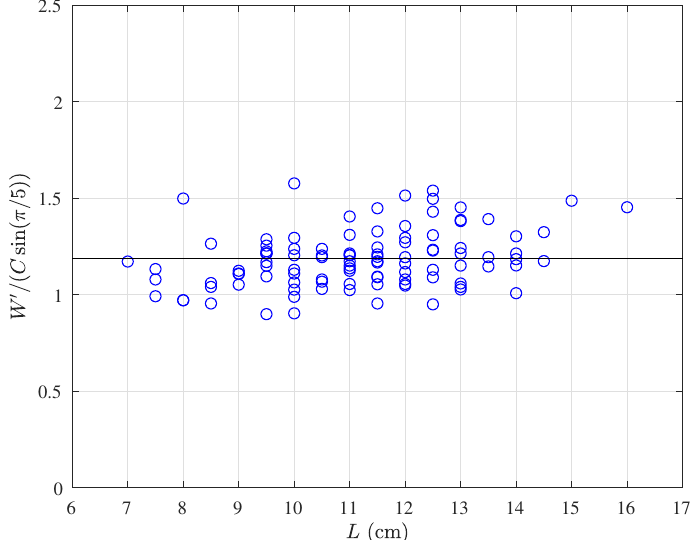
Figure 4. Ratio of measured arm width of Asterias rubens and the size of the central disc scaled with ) . The solid line corresponds to (8). sin ( π 5